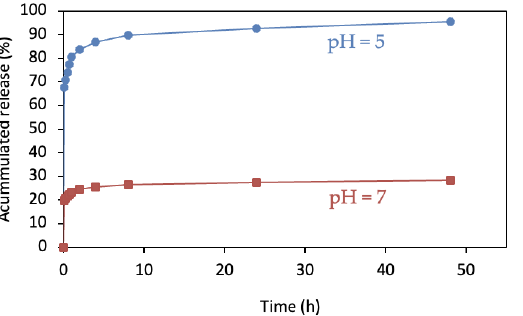
Figure 10. Magnetization test of dry magnetic CIP/ZIF (0.6 mg/mg) with ( a ) and without ( b ) magnet; the same material in water with ( c ) and without ( d ) magnet.